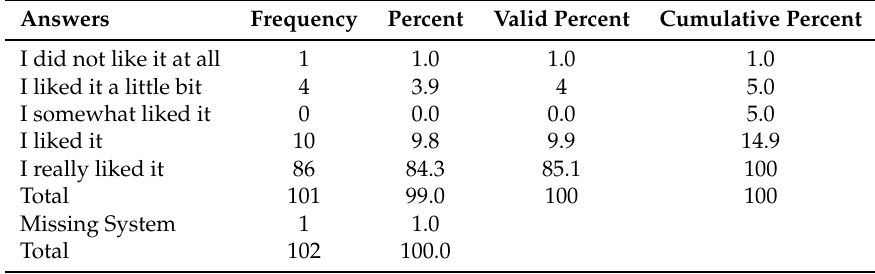
Table 5. Results of the answers of students to the question: How much did you like the game?